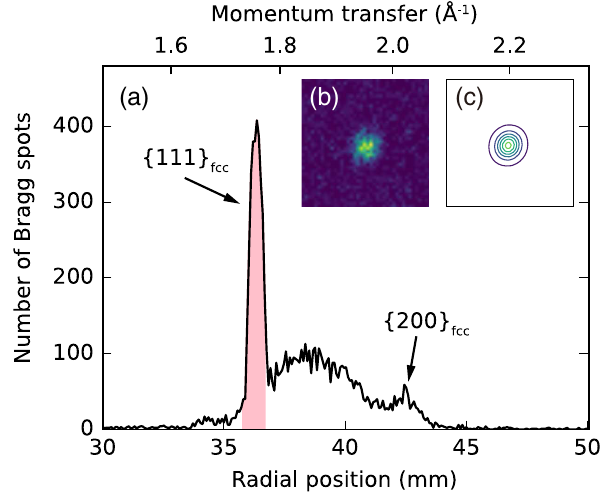
FIG. 1. (a) Radial distribution of the detected Bragg spots from pristine Xe clusters on the detector. The pattern exhibits peaks at positions corresponding to f 111 g and f 200 g reflections. The fcc fcc broad peak around r ≈ 38 mm originates from the rhcp structure [38]. In the subsequent analysis, we only focus on the Bragg spots located on the sharp peak at r ≈ 36 mm (filled with pink). (b) Representative example of a Bragg spot profile in a MPCCD image. (c) 2D Gaussian fit of panel